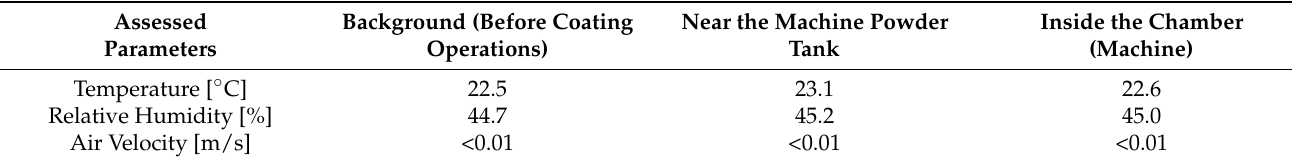
Table 2. Results of the measurements performed with the thermo-hygrometer: air velocity, room temperature, and relative humidity.